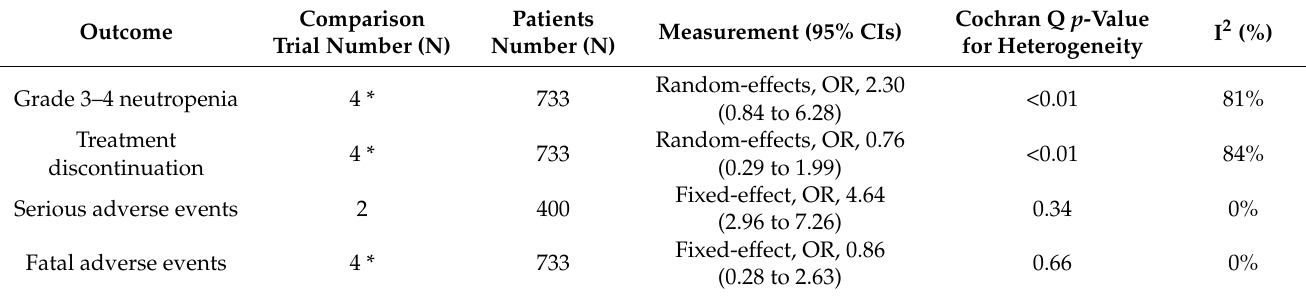
Table 2. Secondary outcomes of